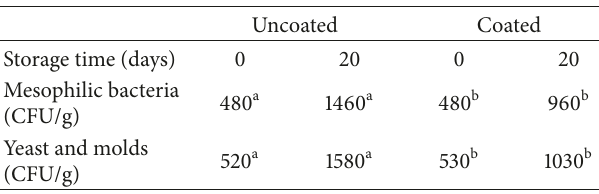
Table 2: Microbial plate counts of uncoated and coated (edible guar gum) Roma tomatoes.